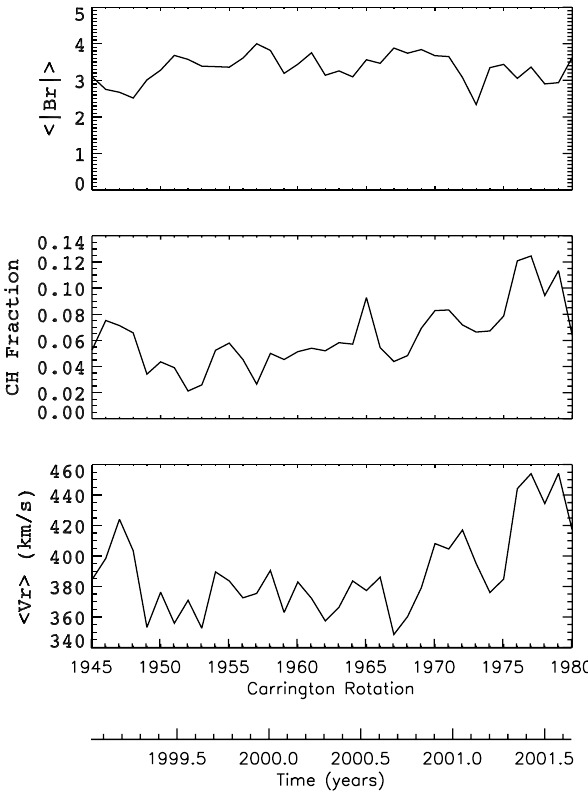
Fig. 5. Evolution of the average magnitude of B r at the photo- sphere, the fractional area covered by coronal holes, and the average radial speed at 30 R S from CR1945 to